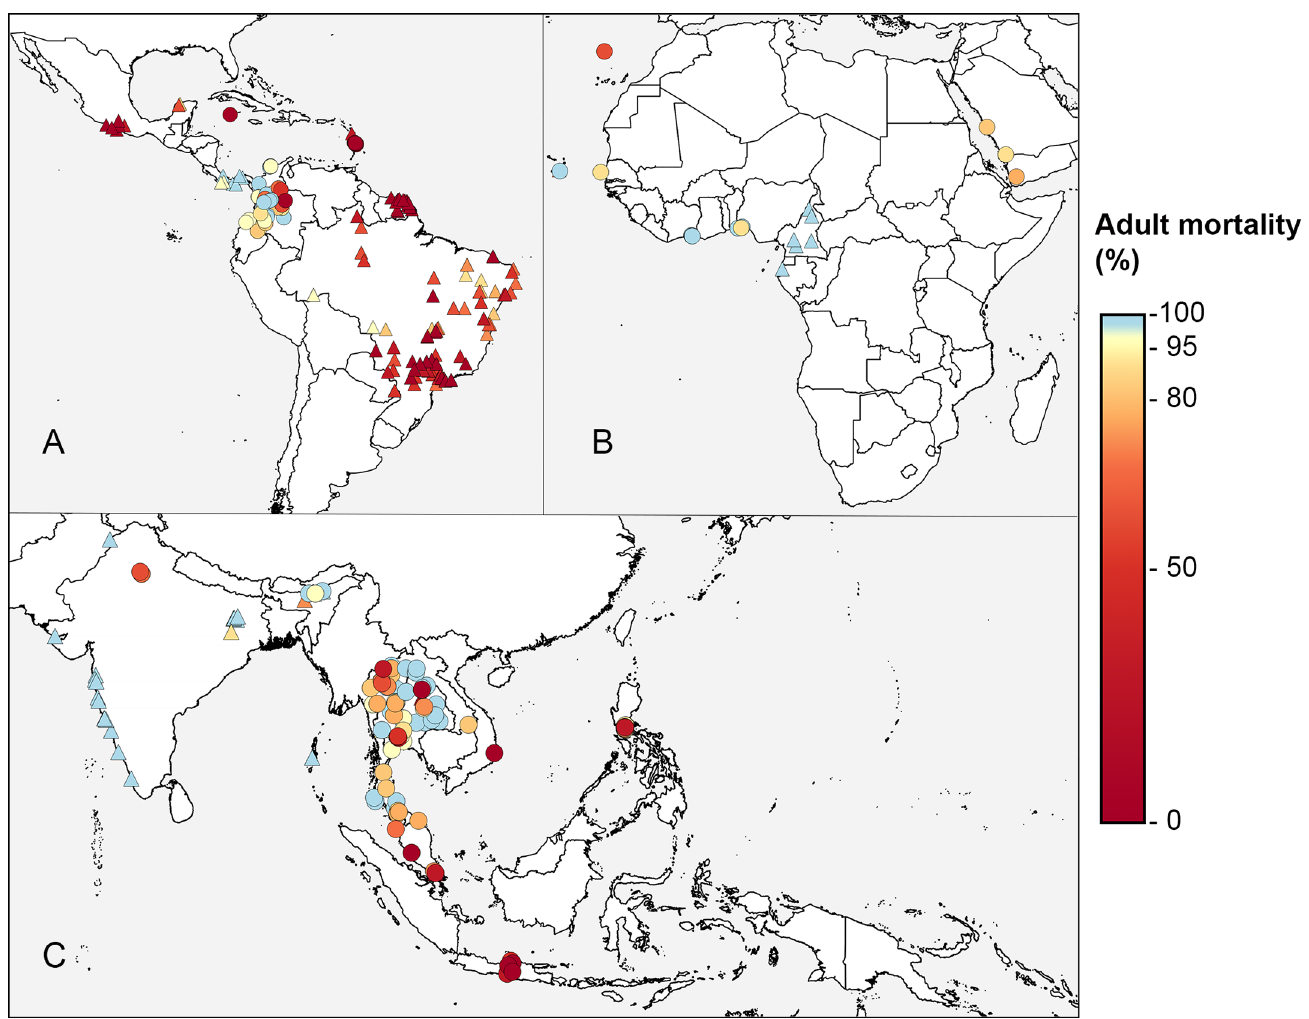
Fig 2. The frequency of resistance to deltamethrin in Ae . Aegypti , 2006–2015. Adult bioassaysusing 0.05% insecticide for 1 hour are denotedas circles and results from nonstandard adult bioassays(including different diagnostic doses and exposureperiods)are denotedas triangles. The map is zoomed to the 3 regionswith data. (A) Americas. (B) Africa/Arabian Peninsula. (C)